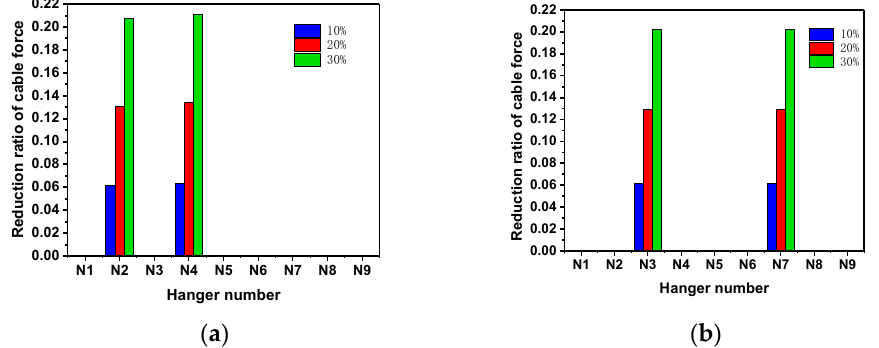
Figure 6. Identification results for DC13–DC18. Identification results for DC1–DC12: ( a ) the preset damage hangers are N2 and N4; ( b ) the preset damage hangers are N3and N7.